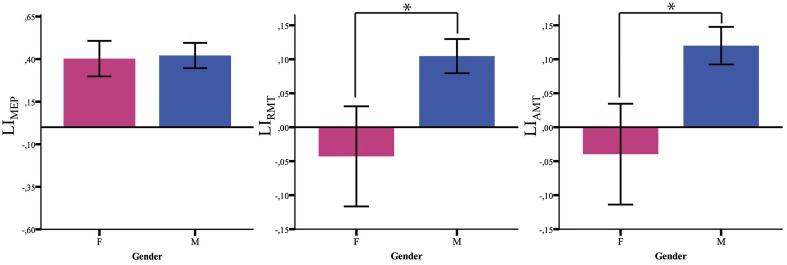
Baseline LI measures. LI baseline measures (MEP, RMT, AMT) in males (blue) and females (pink). *p < 0.05; Error Bars = SER.